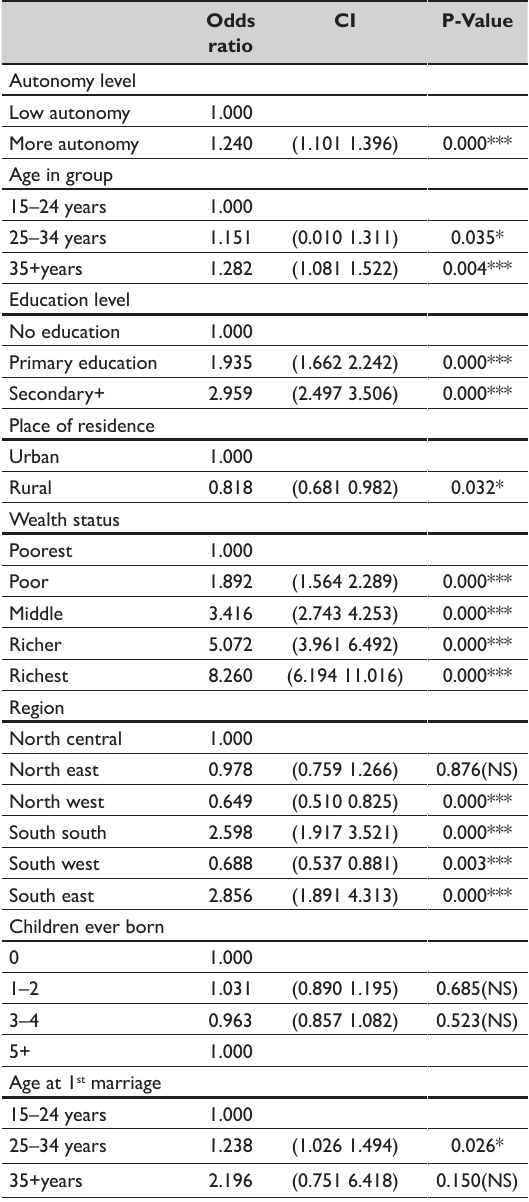
Table 5: Logistic regression analysis for ANC Visits and autonomy status (Adjusted odds